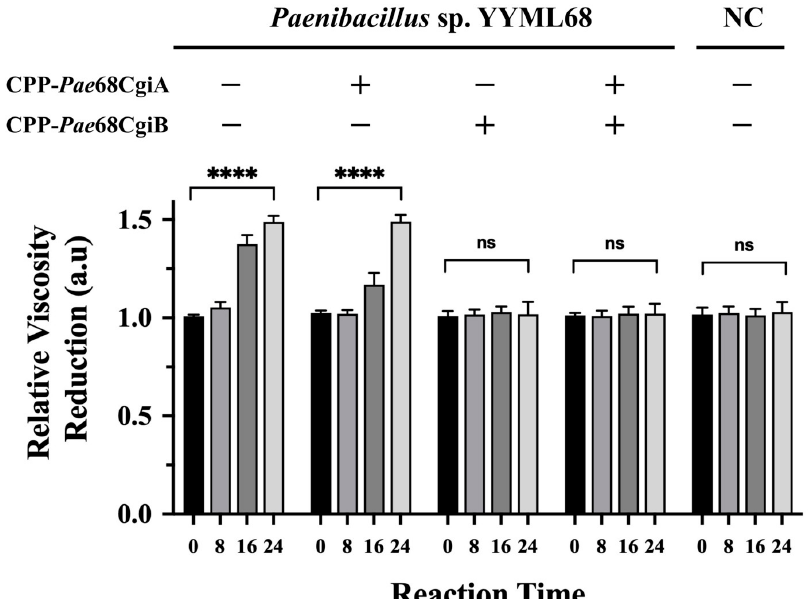
Figure 4. Functional analysis of the ι -carrageenase candidate genes, cgi A and cgi B, via CPP-PNA regulation. The concentration of ι -carrageenan and the designated probes was 1% and 8 µM, respec- tively. Samples were measured at 0, 8, 16 and 24 h time points, and degradation was determined by the reduction of media viscosity in comparison to a non-carrageenan degrading bacterium, Bacillus megateirum (Negative control; NC). All samples were performed in triplicates. Statistical significance ( p < 0.05) was determined by t -test where **** indicates the level of significance. ns: